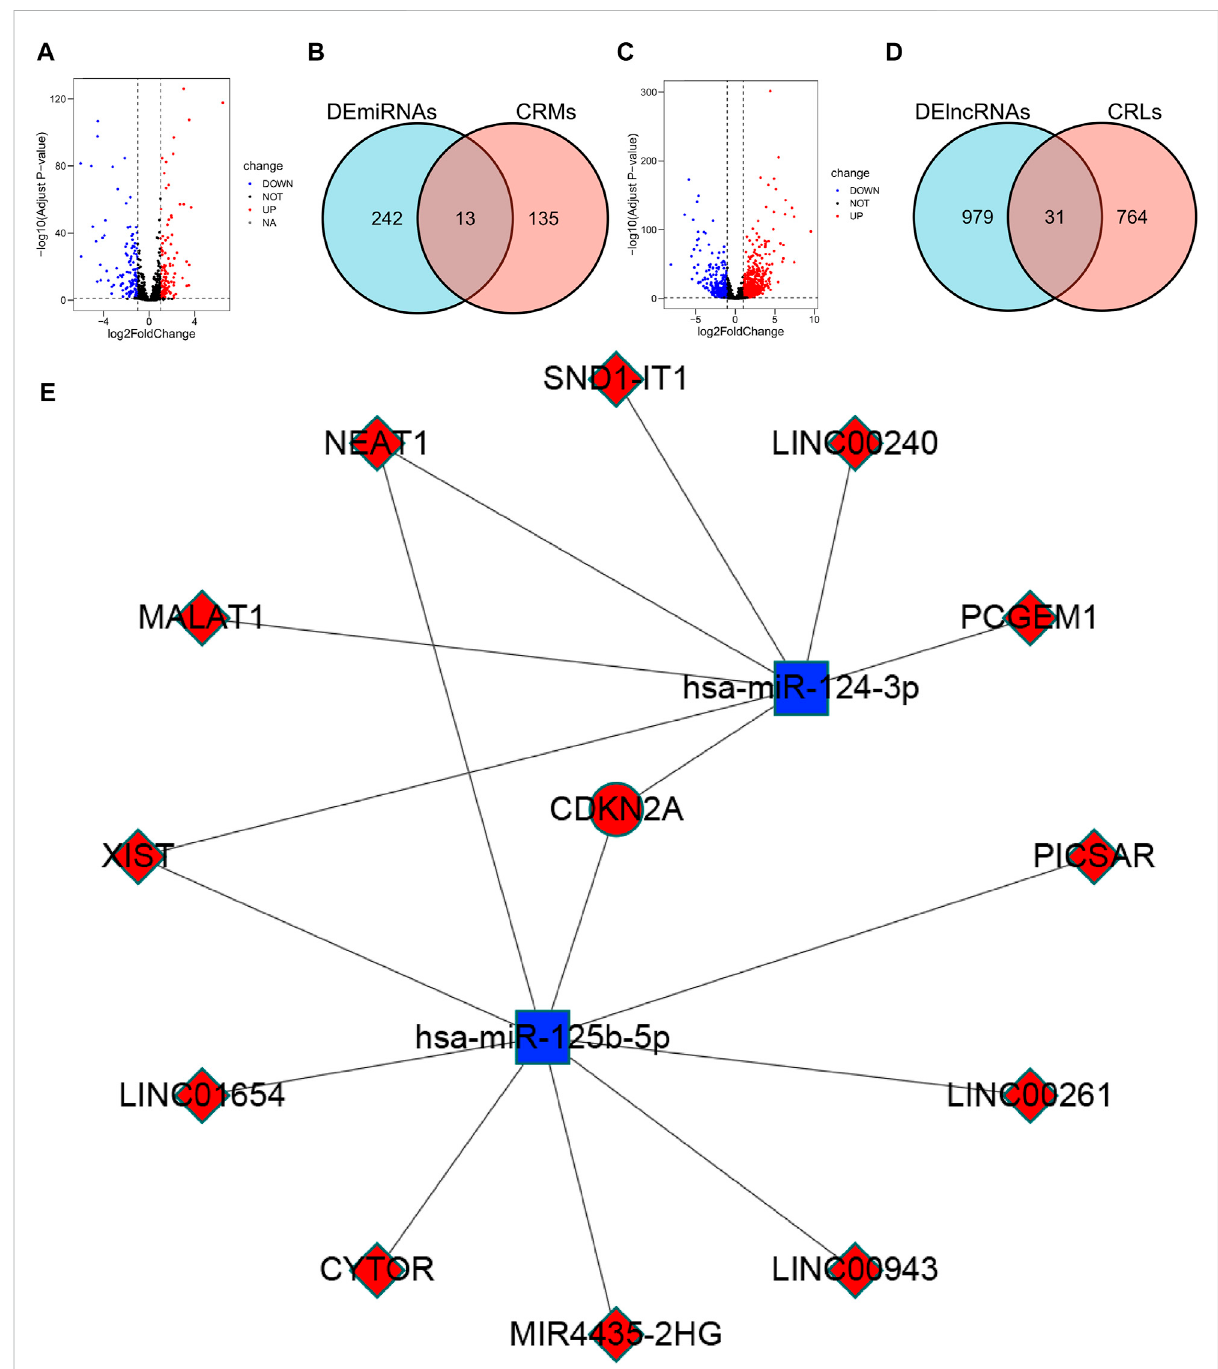
FIGURE 7 ConstructionoftheceRNAnetwork. (A) Volcanoplotof255differentiallyexpressedmiRNAs. (B) VenndiagramoftheintersectionofDEmiRNAs and CRMs. (C) Volcano plot of 1010 differentially expressed lncRNAs. (D) Venn diagram of the intersection of DElncRNAs and CRLs. (E) ceRNA network associated with cuproptosis: red indicates up-regulation in CCRCC, blue indicates down-regulation in